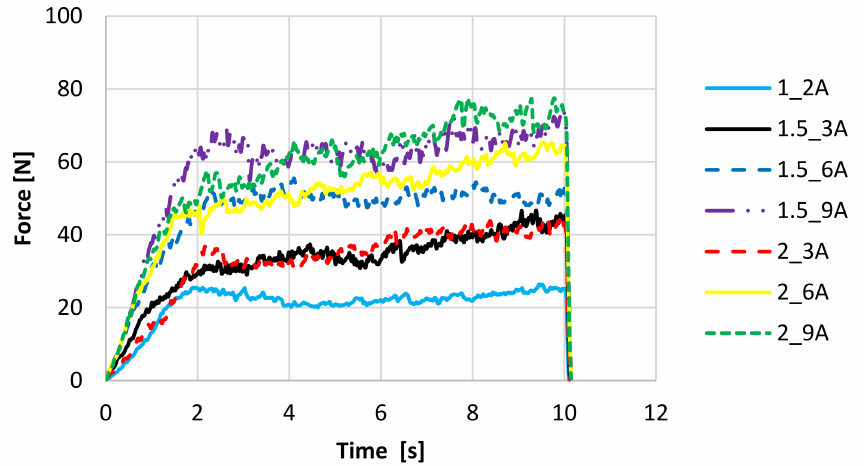
Figure 4. The cutting curves of freeze-dried fruit bars with apple pomace. Denotations in Table 1 include Index (A) next to the sample symbol—bars with the apple pomace.